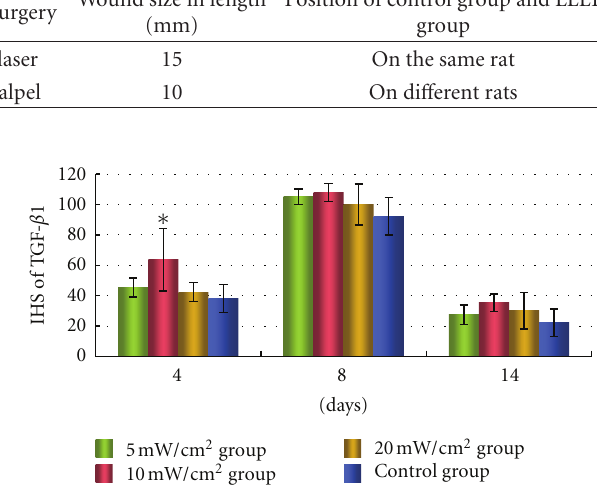
Figure 8: Immunohistochemical score (IHS) of TGF- β 1 protein expression throughout the experiment. Asterisk means that this group has statistical di ff erence with control group ( P < 0 .